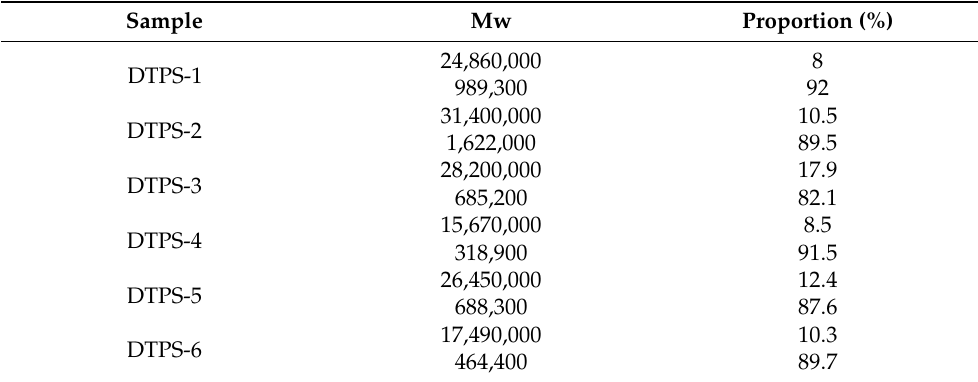
Table 3. The molecular weight distribution of the